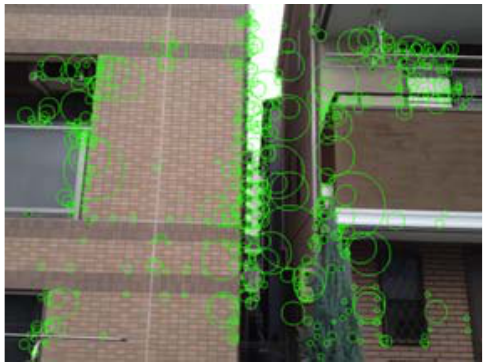
Figure 3. Feature points extraction by SURF Even if the SURF is applied to feature points extraction and tracking, incorrect matching points are still exist. The feature points tracking are refined by using not only adjacent frames searched in sequence between adjacent